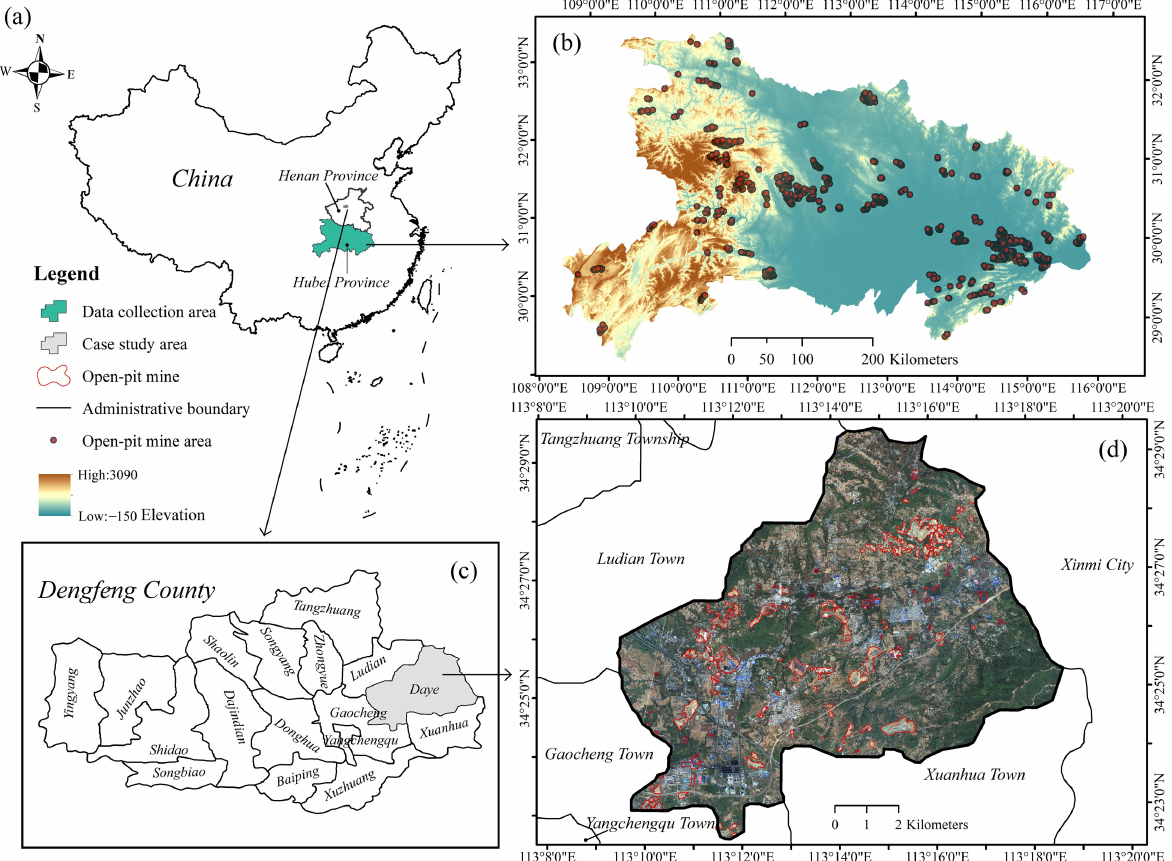
Figure 1. Geo-location and open-pit mine distribution of dataset and case study area. ( a ) Location of the KOMMA dataset collection area and study area in China; ( b ) key open-pit mine acquisition areas in Hubei Province; ( c ) location of Daye Town in Dengfeng County; ( d ) open-pit mines in Daye